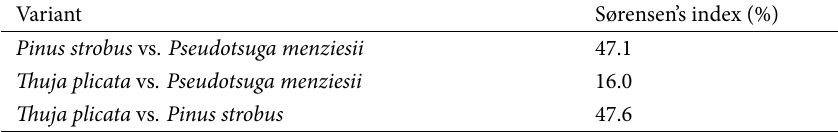
Table 6 Sørensen’s index of similarity among the tree species in the assessed sites.